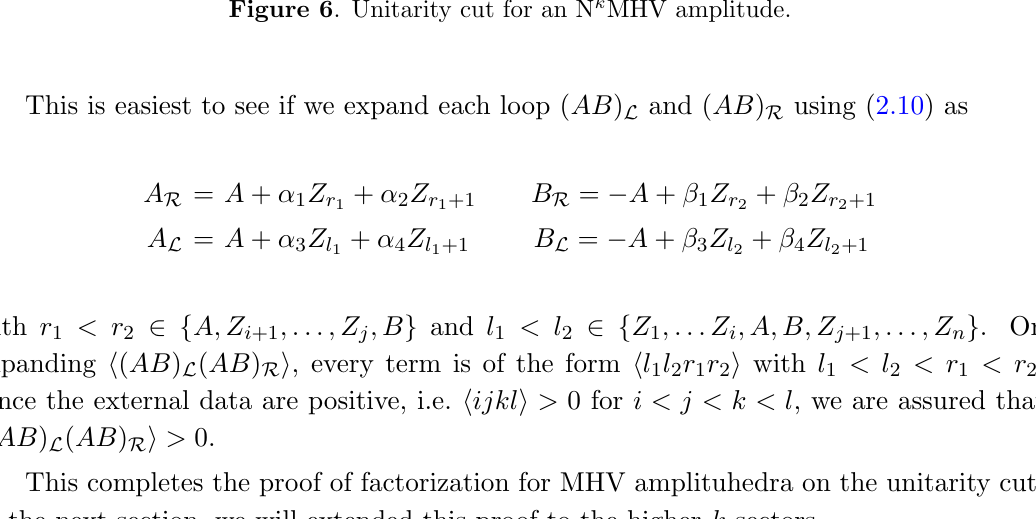
Figure 6 . Unitarity cut for an N k MHV